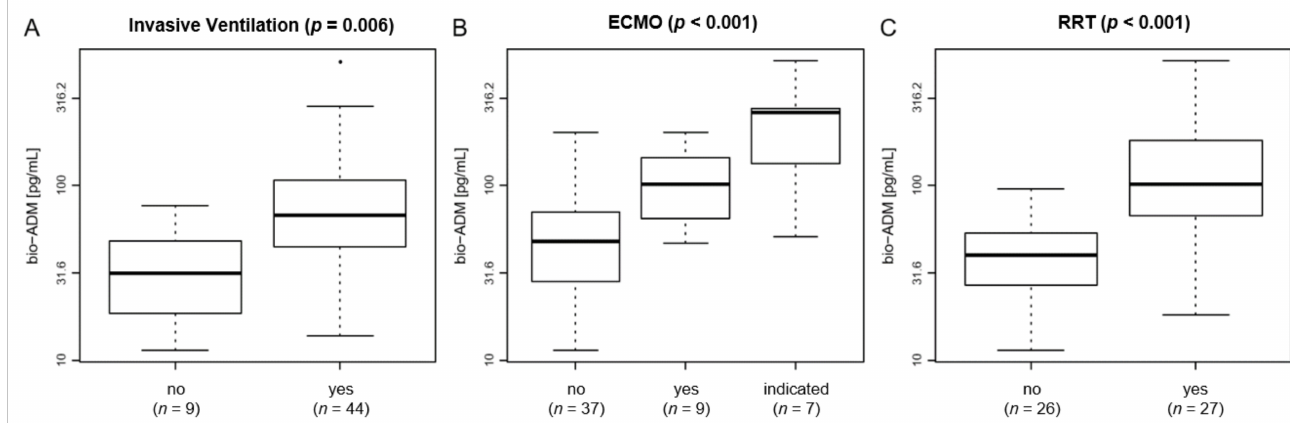
Figure 2. Boxplot of bio-ADM levels by ( A ) invasive ventilation ( p = 0.006); ( B ) ECMO ( p < 0.001); and ( C ) RRT ( p < 0.001) in 53 COVID-19 patients upon ICU admission. The distributions of bio-ADM are shown as boxes, with the lower end of the boxes representing the 25th and the upper end of the boxes representing the 75th percentile (interquartile range), the middle line representing the median, and the whiskers showing the minimal and maximal bio-ADM levels. Outliers are shown as circles plotted beyond the whiskers. Patients who fulfilled the criteria for ECMO therapy but did not receive ECMO treatment were termed “indicated”. The y axis uses a logarithmic scale. bio-ADM: bioactive adrenomedullin; ECMO: extracorporeal membrane oxygenation; ICU: intensive care unit; RRT: renal replacement